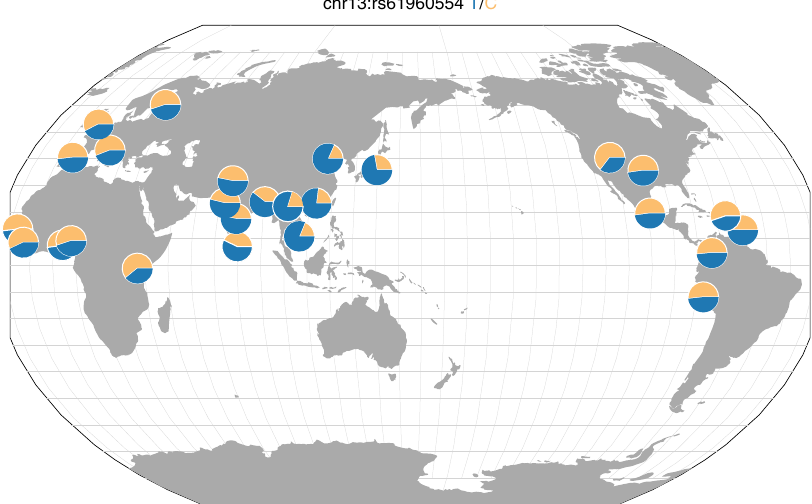
Fig. 3 Characterization of the multifunctional variant at the TBC1D4 locus. a Comparative sequence analysis shows three variants within 7 bp, the insertion of a C and two C>T transitions that are only found in Homo sapiens , not in any other primate or Denisovan DNA, while the one Neanderthal read at the locus also shows the ancestral C. The ancestral haplotype encodes a canonical NF κ B binding site, with the human-speci fi c haplotype disrupting it in three locations. In b , using data from the GGV browser 50 , we observe that while the ancestral allele is the more common in European and African populations, in South and East Asia the human-speci fi c allele becomes substantially more common in these